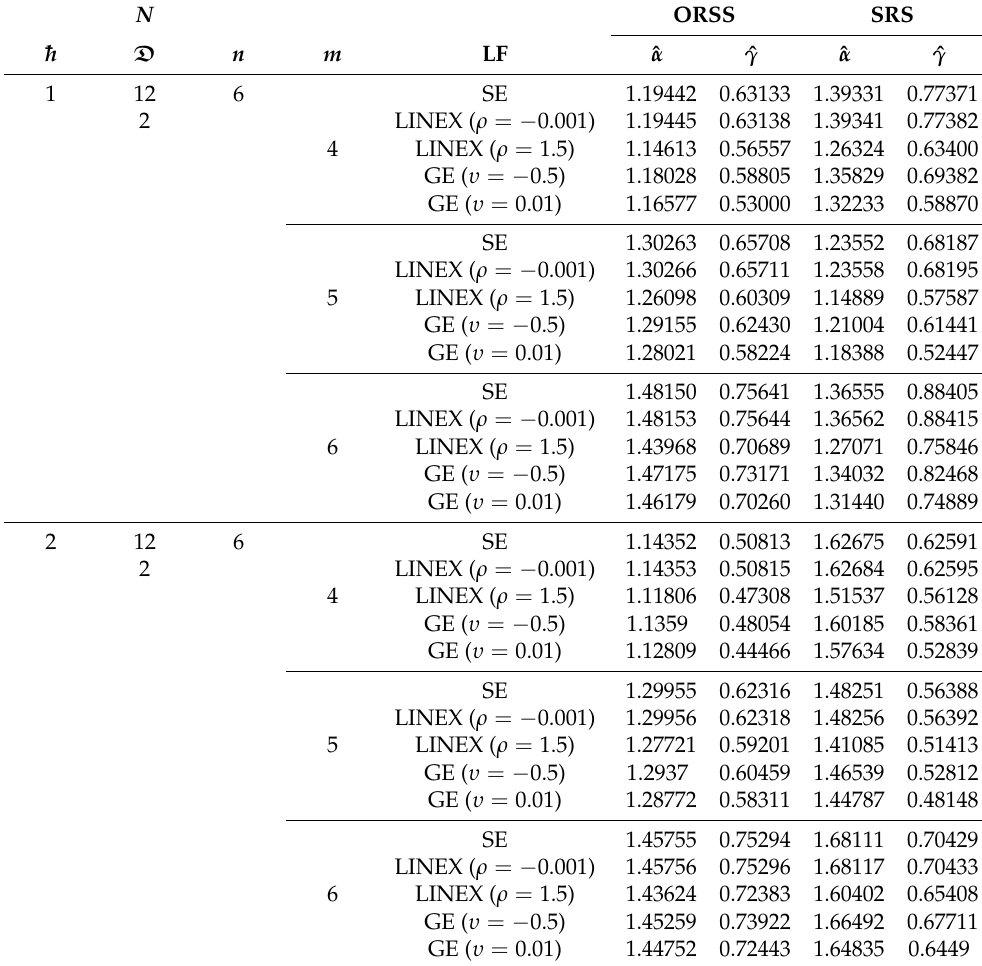
Table 2. BEs of α and γ based on SRSs and ORSSs (one-cycle and two-cycle) presented in Table